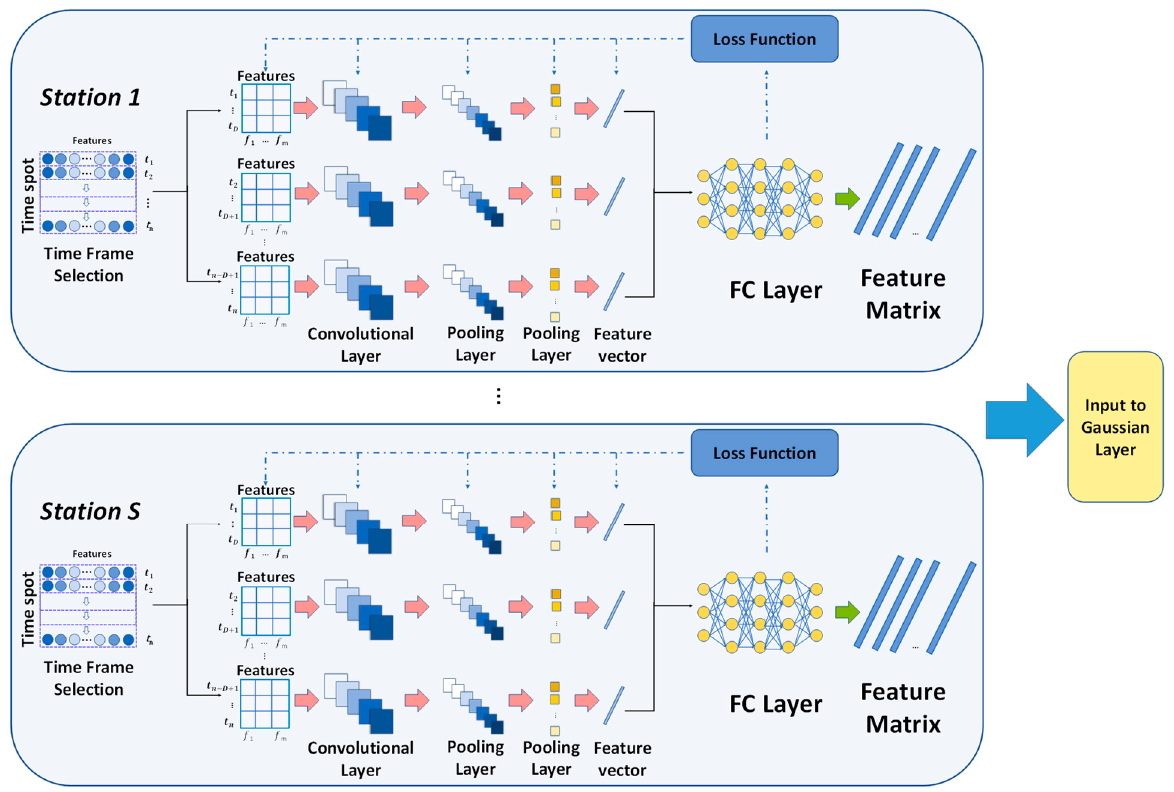
Figure 3. CNN structure of the model.